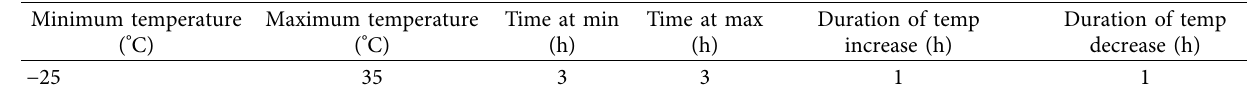
Table 2: Freeze-thaw parameter settings.